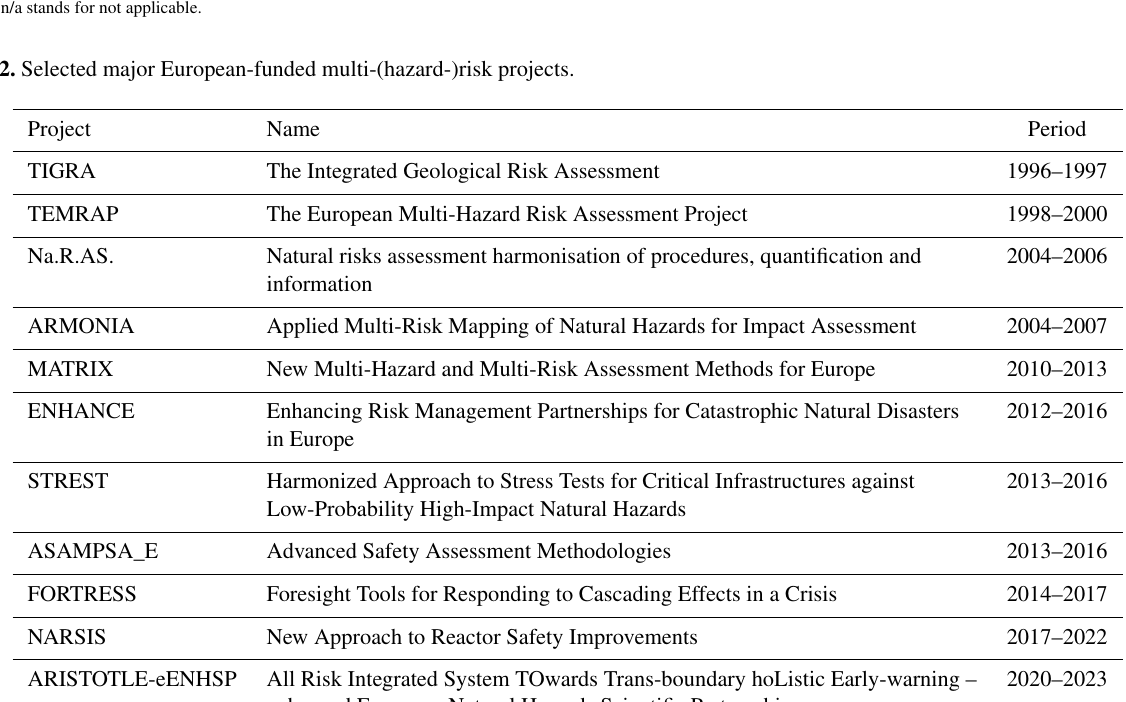
Table 2. Selected major European-funded multi-(hazard-)risk projects.